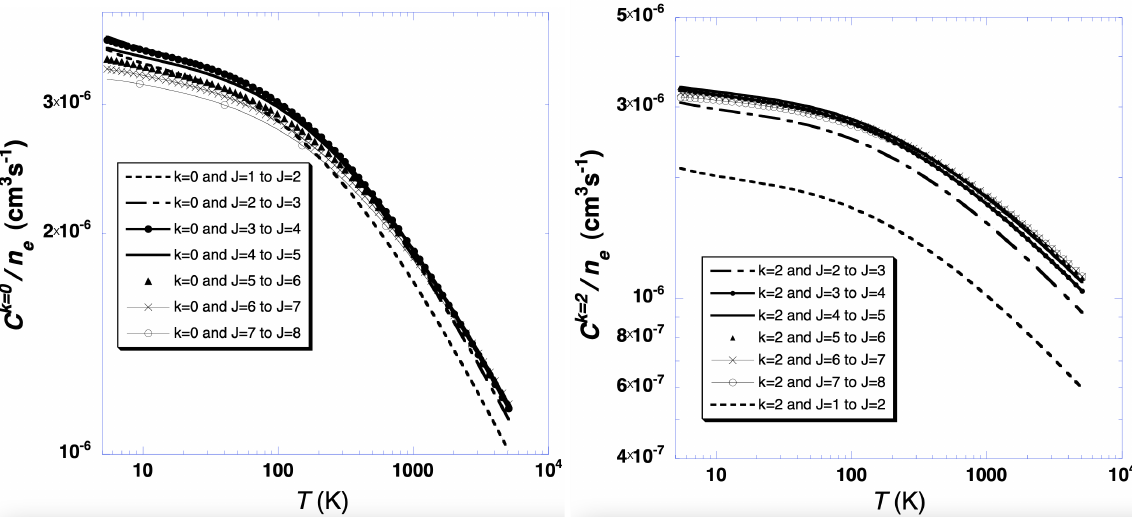
Figure 2. Plot, on a logarithmic scale, of the rotational elastic rates D k due to isotropic collisions of the X 1 Σ + SiO with electrons for 5 K ≤ T ≤ 5000 K. All rates are similar except the case of the rate with k = 2, j = 1 and j (cid:48) = 2. Let us notice that for the state X 1 Σ + , one has N = j since S m =